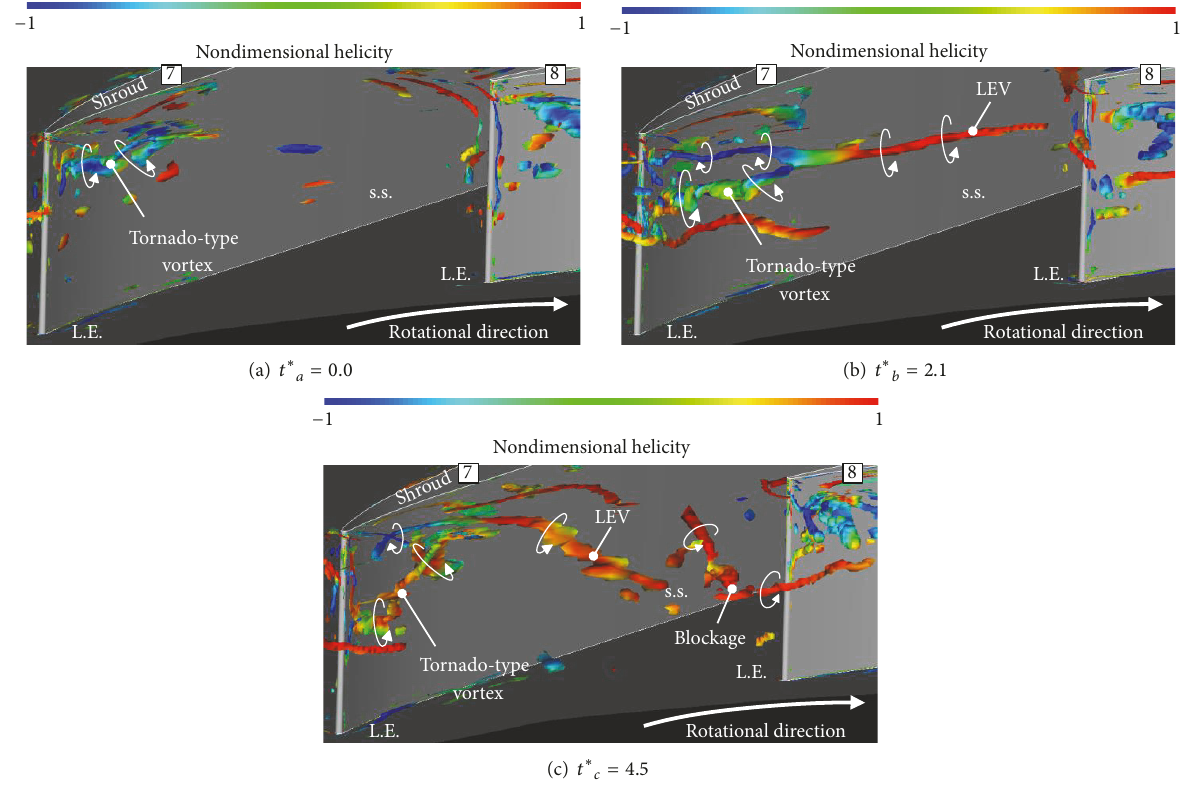
Figure 10: Instantaneous vortical structure within diffuser passage numbers 7-8 at nondimensional time 𝑡 ∗ 𝑎 , 𝑡 ∗ 𝑏 , and 𝑡 ∗ 𝑐 .